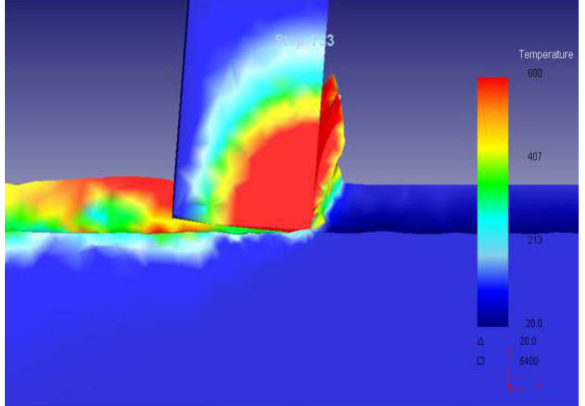
Fig. 5. The picture of thermal phenomena in the contact zone of the cutting coated tool at cutting speed V = 450 m / min